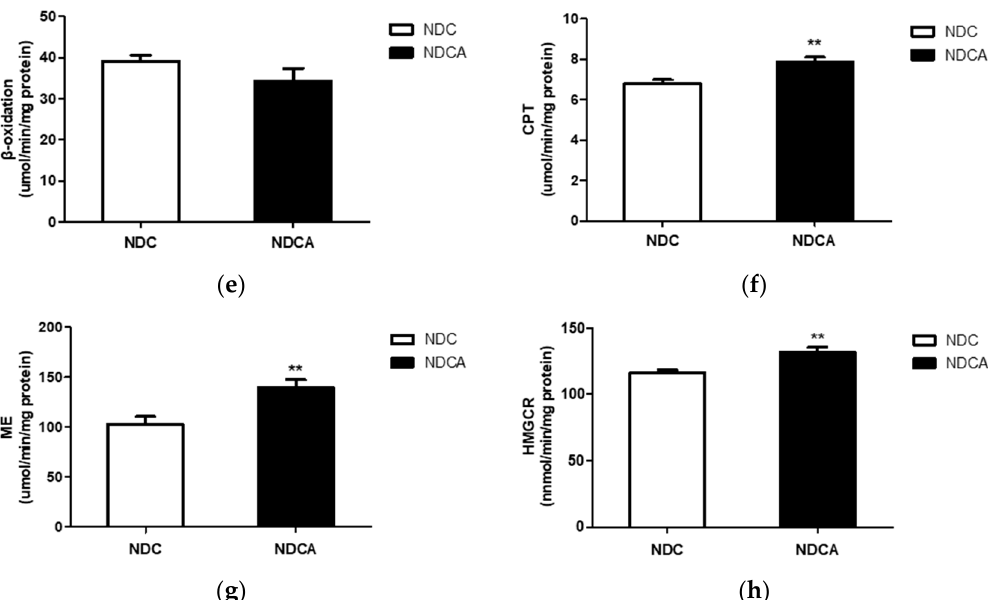
Figure 6. E ff ect of supplementation of non-dairy creamer-enriched high-fat diet with D-allulose on lipid-regulating enzyme activities in hepatic tissue in C57BL / 6J mice fed the diet for 8 weeks: ( a ) glucose-6-phosphate dehydrogenase (G6PD) activity; ( b ) phosphatidate phosphatase (PAP) activity; ( c ) acetyl-coenzyme A acetyltransferases (ACAT) activity; ( d ) fatty acid synthase (FAS) activity; ( e ) β -oxidation activity; ( f ) carnitine palmitoyltransferase (CPT) activity; ( g ) malic enzyme (ME) activity; ( h ) 3-hydroxy-3-methyl-glutaryl-coenzyme A reductase (HMGCR) activity. Data are mean ± SE. Significant di ff erences between the 5% D-allulose group and without D-allulose group are indicated; * p < 0.05, ** p < 0.01, *** p < 0.001. NDCA, high-fat diet with non-dairy creamer + 5% D-allulose; NDC, high-fat diet with non-dairy creamer.